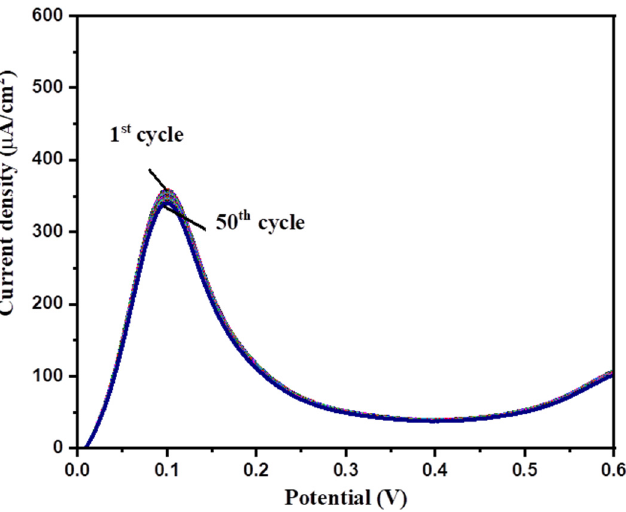
Figure 9. Fifty consecutive LSV curves of MnO 2 /rGO/GCE in 50 µM 4-NP (scan rate = 50 mV/s).